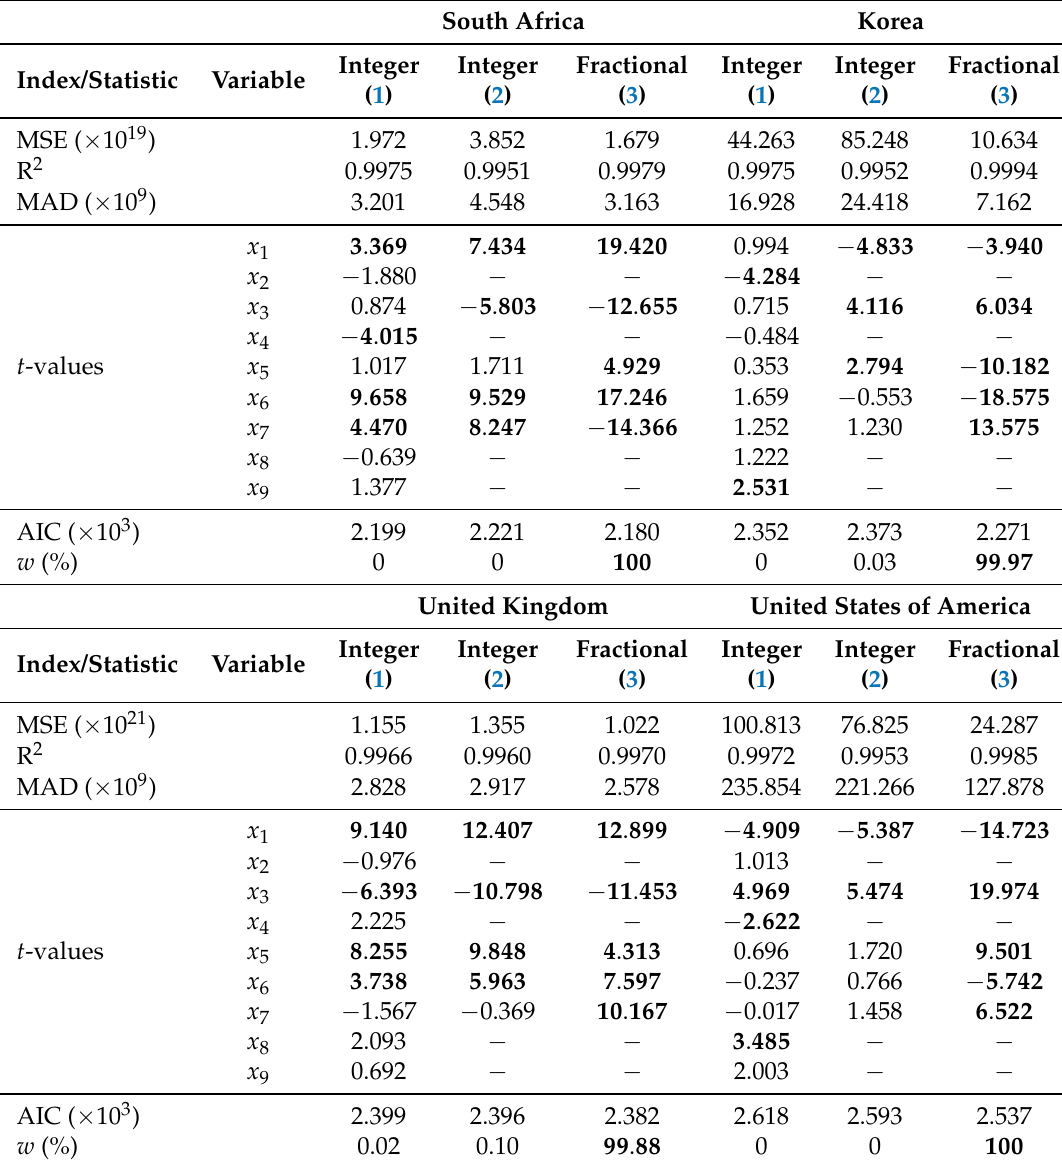
Table 3. Performance indices of the different models obtained for the G20 members in Figure 4; for an explanation of performance assessment see Section